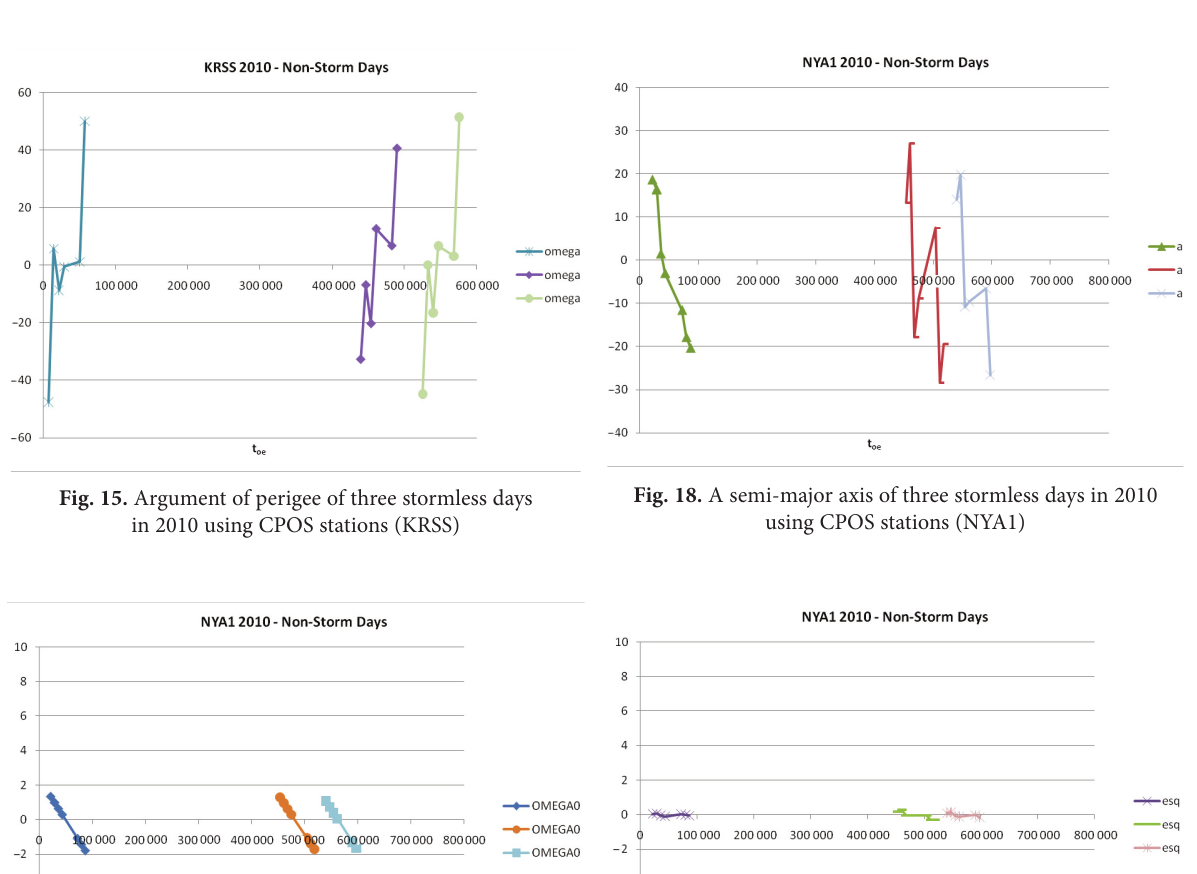
Fig. 14. The eccentricity of three stormless days in 2010 using cPOS stations (KRSS)